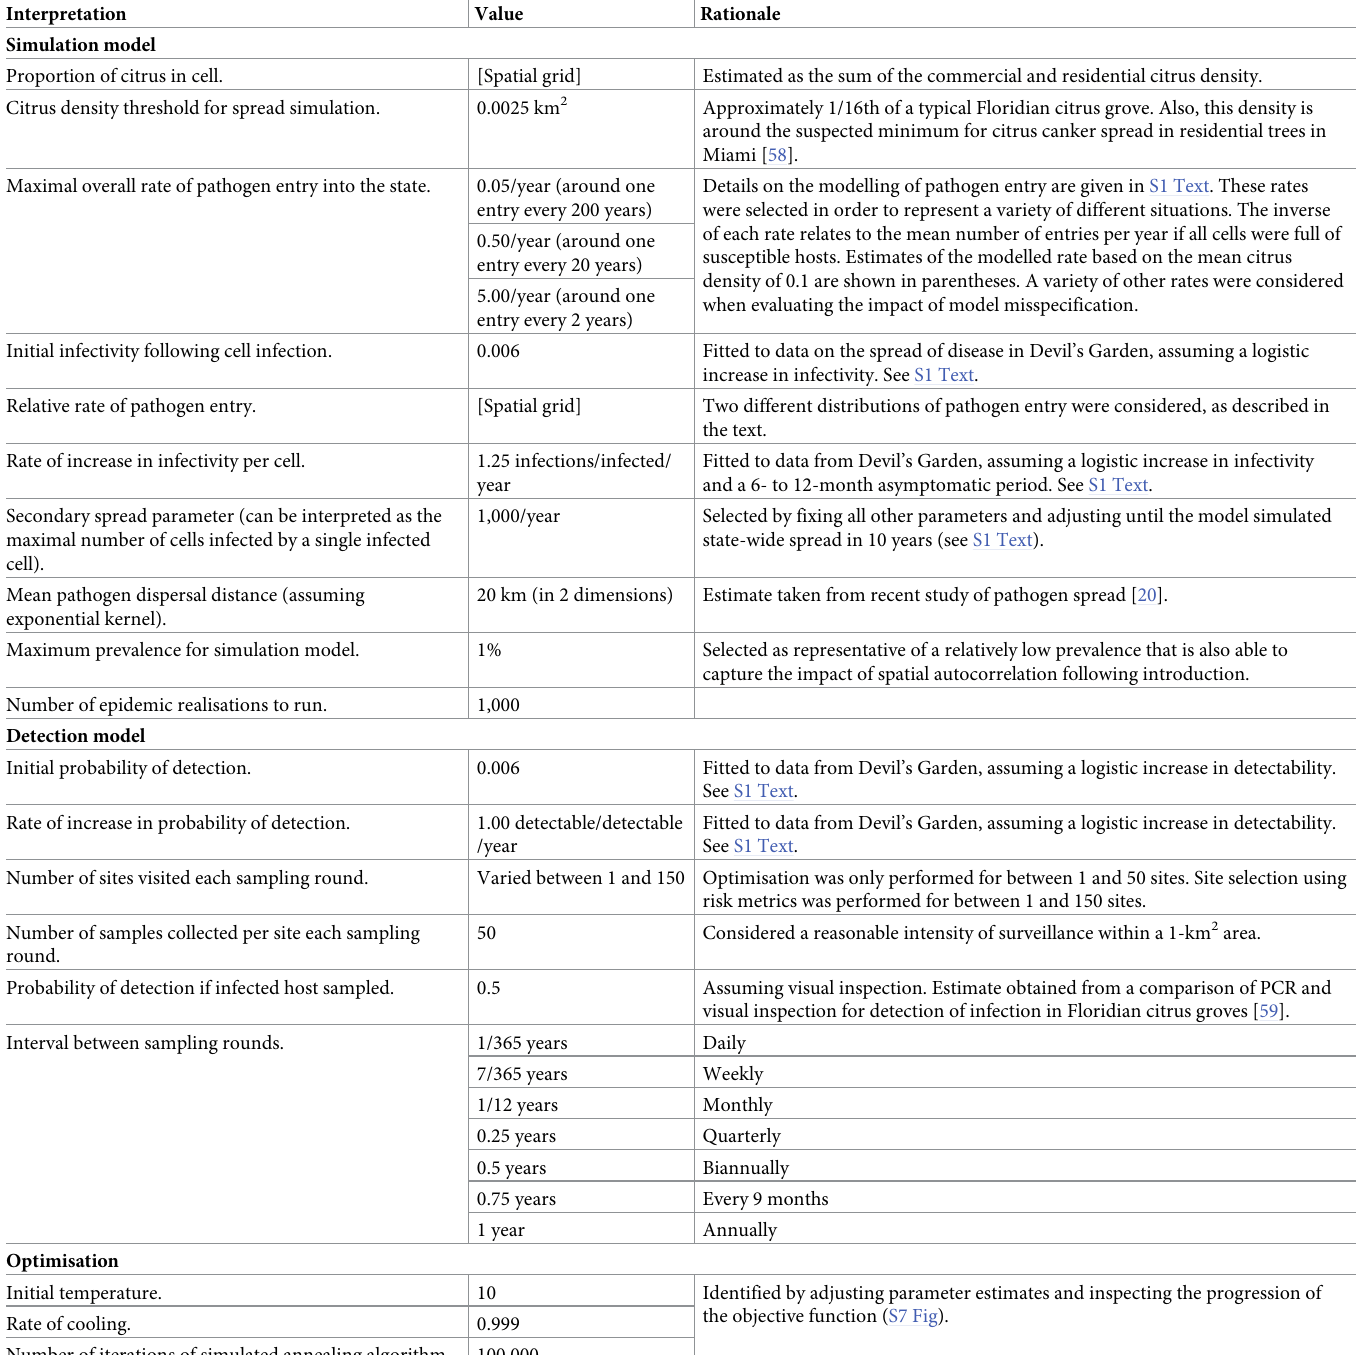
Table 1. Description of parameters used in the